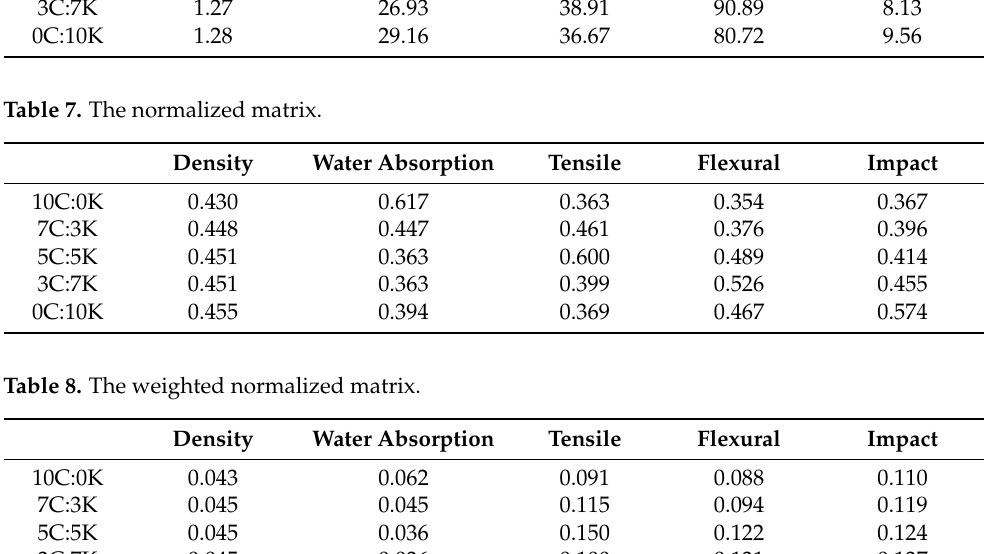
Table 6. Decision matrix.